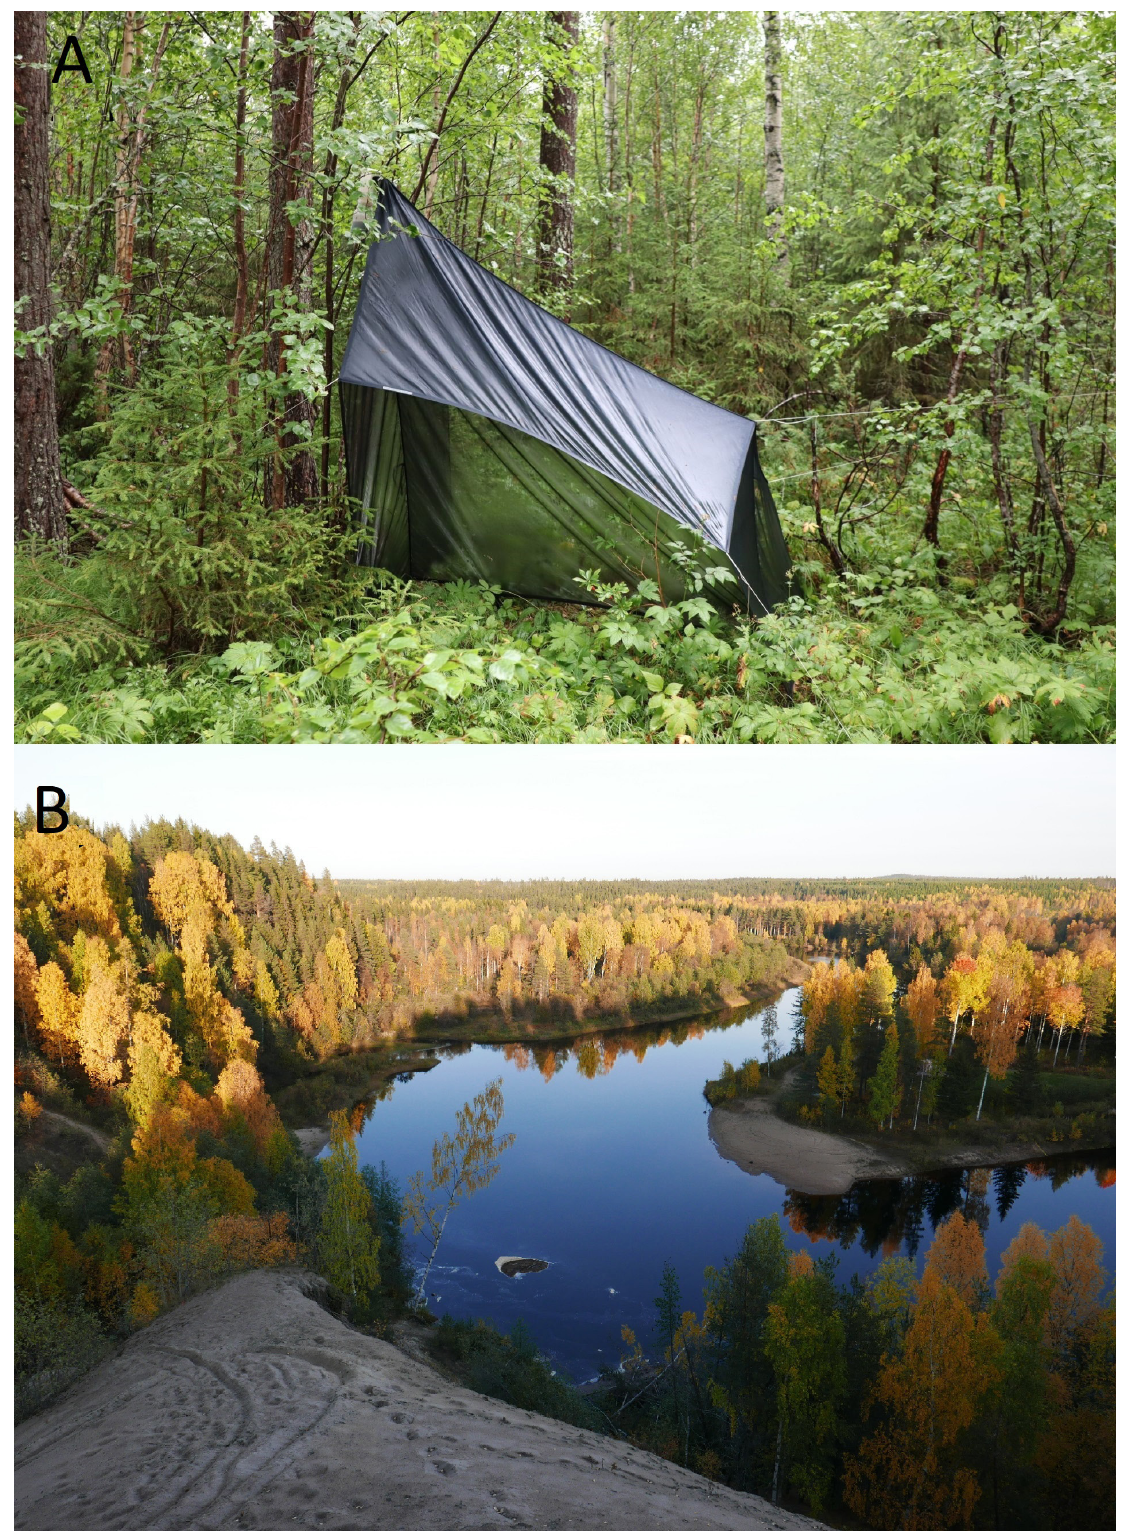
Fig. 12. A . Malaise trap at Hästholmen by the forest river Byskeälven. Type locality for Homotropus hellqvisti sp. nov. and Homotropus mugerwai sp. nov. Photo: Roger Mugerwa Pettersson. B . The Natura 2000 area Byskeälven from Marranäsvältan. Photo: Sören Uppsäll,